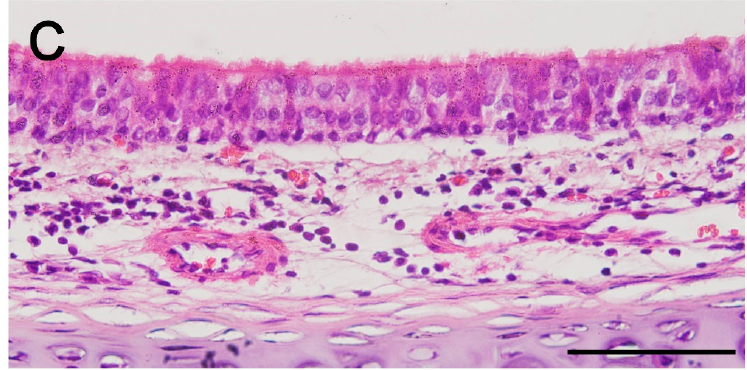
Figure 6. Histopathologic findings. Microscopic images of MSC group ( A ) and d-MSC group ( B ) showed newly formed respiratory epithelium in both groups. Regenerated epithelium in A and B had a rough cell arrangement compared with that of the normal trachea ( C ) but ciliated columnar epithelium was confirmed (Hematoxylin and eosin staining; all scale bars indicate 50 µm).